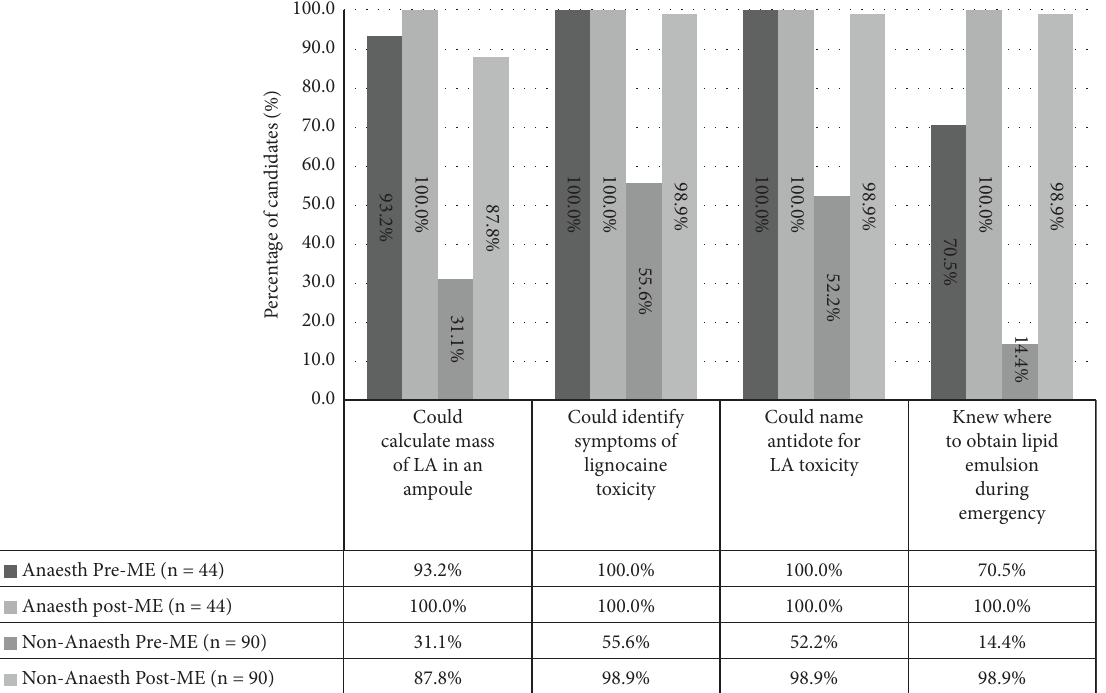
Figure 3: Percentage of trainees who correctly answered several questions within the